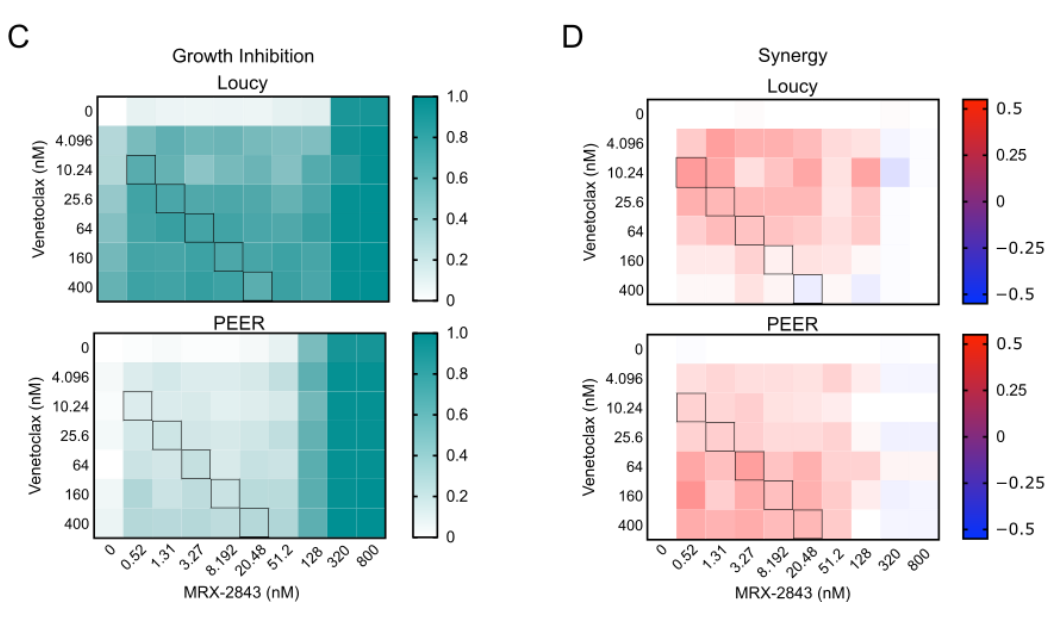
Figure 4. MRX-2843 and venetoclax mediate synergistic anti-leukemia activity in ETP-ALL cell lines. ( A , B ) Loucy cells were plated in triplicate at 20,000 cells/well and cultured for 24 h before treatment with vehicle, MRX-2843 (low = 62.5 nM, high = 125 nM), venetoclax (low = 250 nM, high = 500 nM), or MRX-2843 and venetoclax combined for an additional 48 h. After treatment, cells were stained with CellTiter-Glo reagent, luminescence was measured, and cell numbers were calculated relative to the DMSO control. Mean values ± SEM were derived from four independent experiments. For ( B ), expected additive values were calculated using the fractional product method and compared with experimentally observed values (** p ≤ 0.01, *** p ≤ 0.001, **** p ≤ 0.0001, unpaired t -test). ( C , D ) ETP-ALL cell lines (Loucy and PEER) were treated in quadruplicate with pairwise drug combinations of MRX-2843 and venetoclax, and relative cell numbers were determined utilizing a high-throughput platform and the CellTiter-Glo readout. ( C ) Relative growth inhibition was calculated by subtracting background luminescence and normalizing to vehicle controls. ( D ) Synergy was calculated using the Response Additivity model. Values >1% indicate synergistic, values <−1% are antagonistic, and all others are additive. Black boxes in ( C , D ) represent combinations of MRX-2843:venetoclax at a 1:20 dose ratio. Abbreviations: ns – not significant